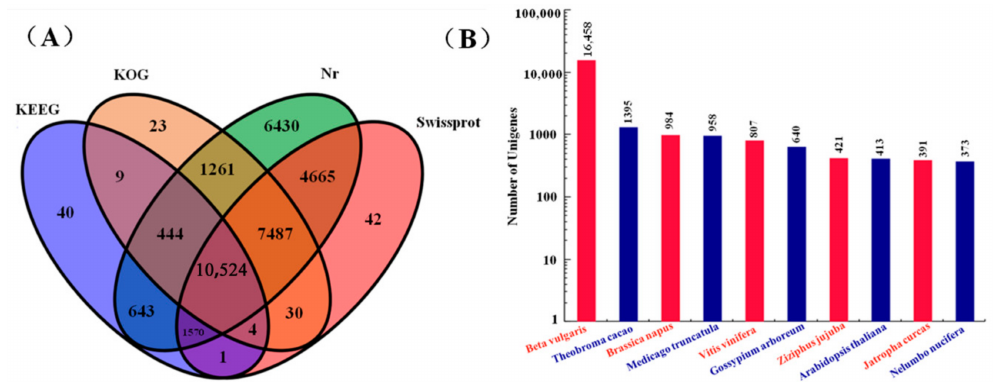
Figure 3. Annotation of genes in various databases and statistics of homologous genes. ( A ) Annotation of M. himalaica transcriptome library assembly genes in different databases. ( B ) Statistics on the number of homologous genes between M. himalaica and other